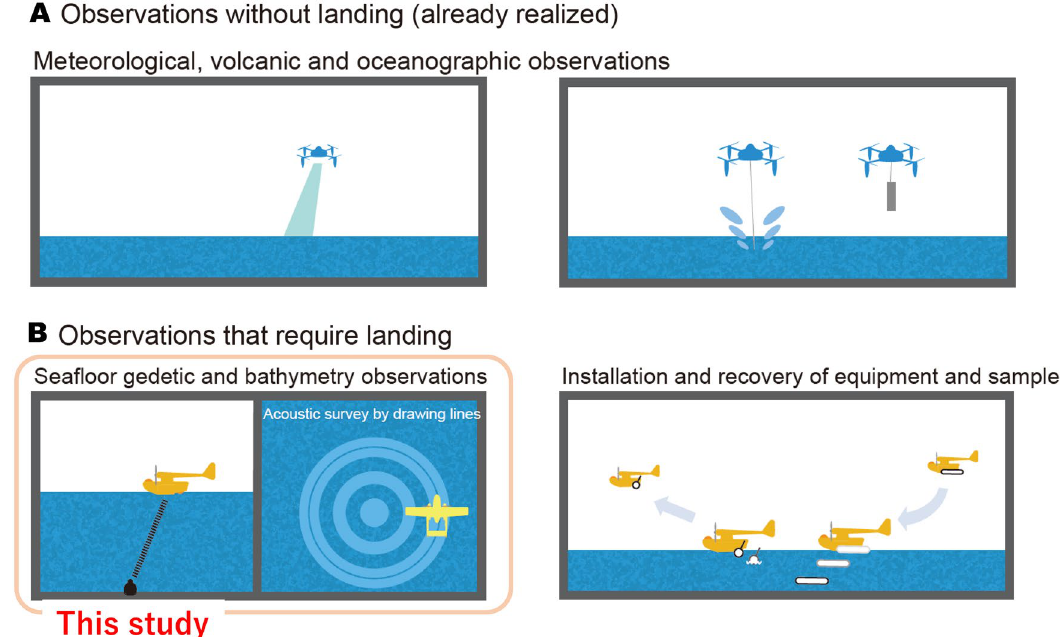
Figure 2. Schematic of UAV ocean observations. ( A ) Observations without landing (already in operation). ( B ) Observations that require landing. Seafloor geodetic and bathymetry observations and the installation and